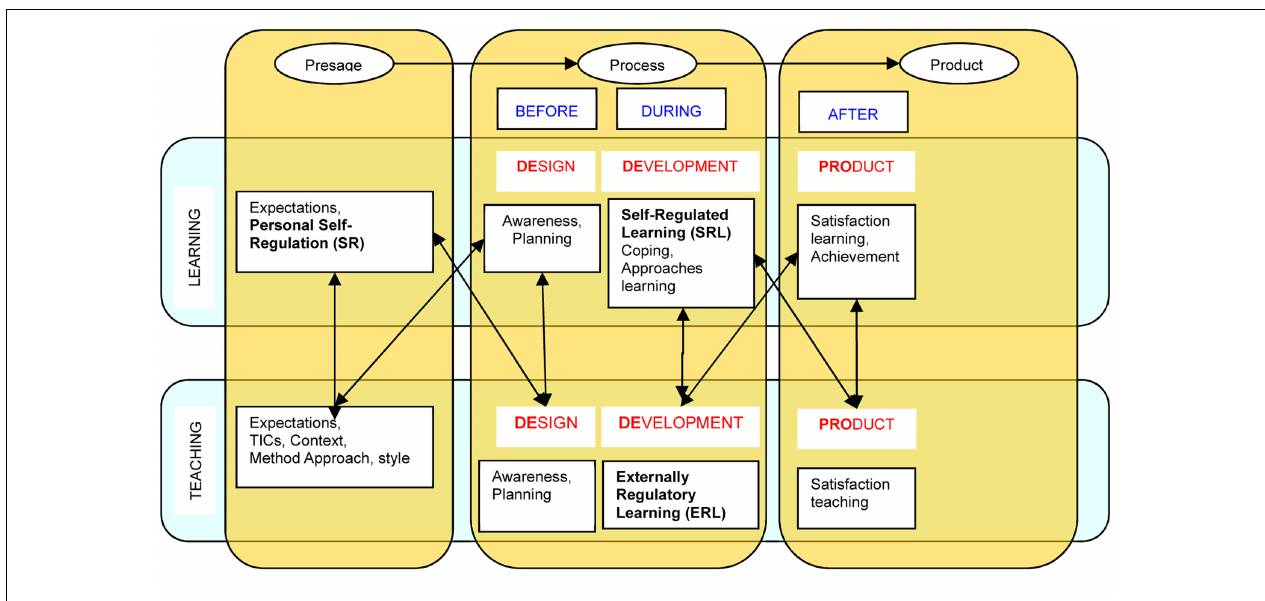
FIGURE 1 | Variables of the Theory of Self- vs. Externally-Regulated Learning (SRL vs. ERL) in the context of the 3P and DEDEPRO model (de la Fuente and Justicia, 2007, p. 545).